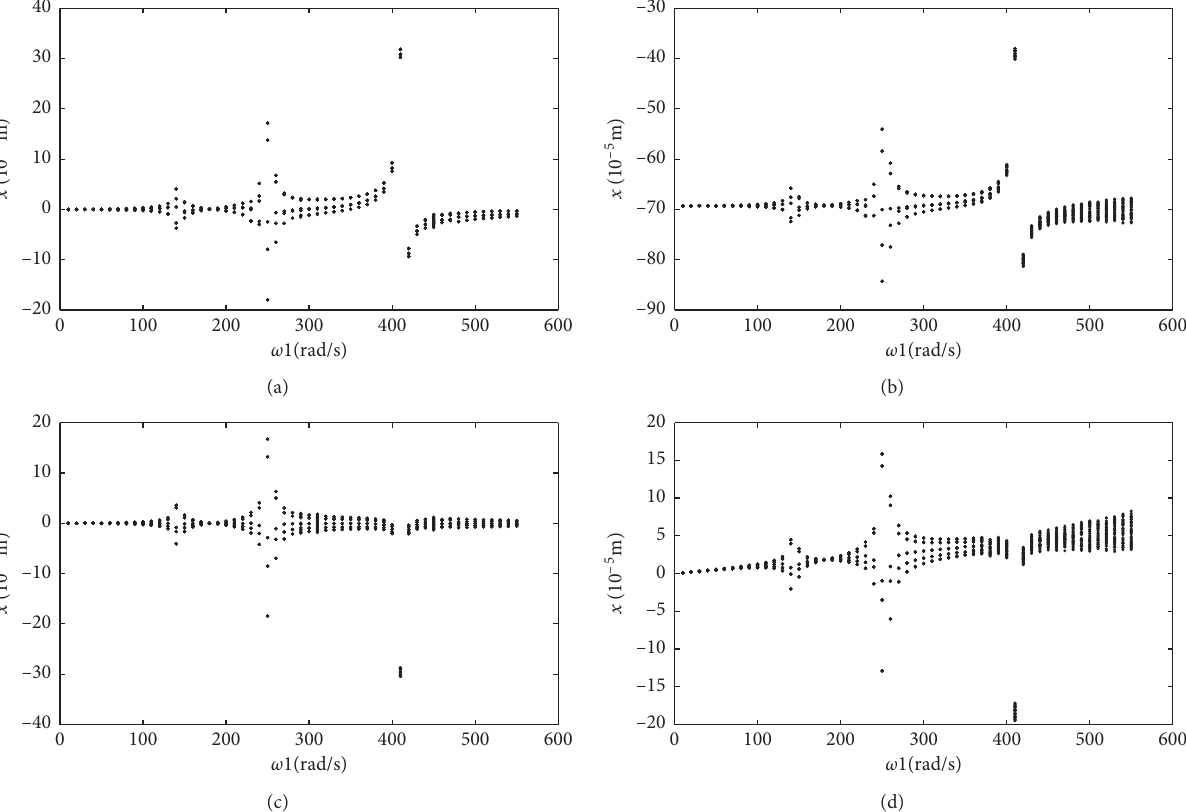
Figure 16: Bifurcation diagrams for the vibration of disk 4. (a) Horizontal response, straight flight. (b) Horizontal response, hovering. (c) Vertical response, straight flight. (d) Vertical response,